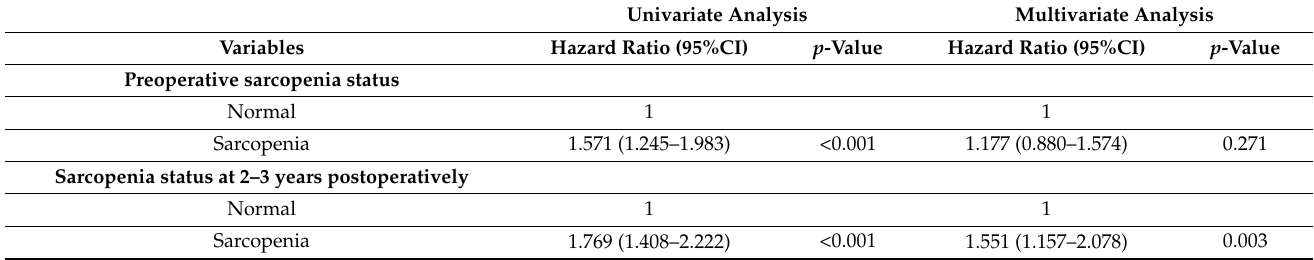
Table 2. Risk factors associated with recurrence-free survival (N = 2333, recurrence =